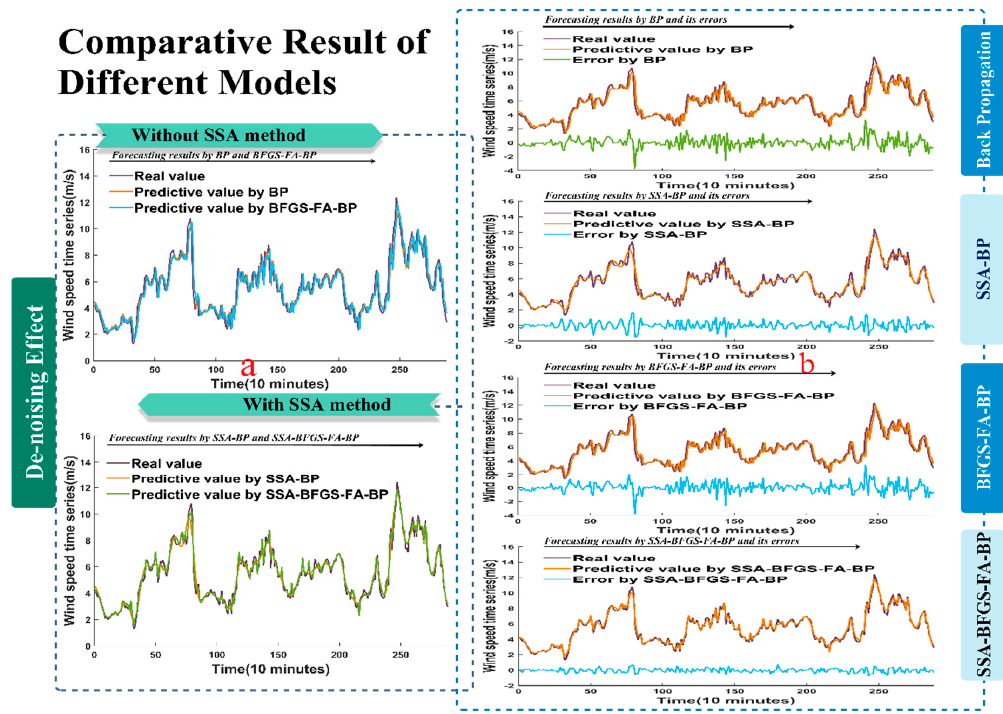
Figure 6. The forecast results for wind speed collected from site 3 at 10-min intervals. ( a ) The forecast effect without SSA algorithm and with SSA algorithm; ( b ) The comparison between the forecast values and the raw data and their corresponding errors.